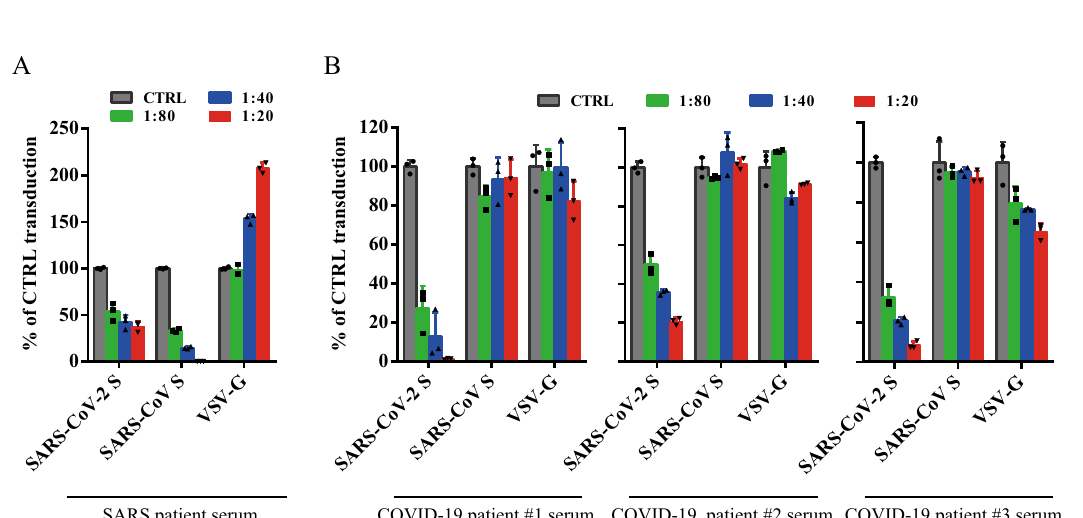
Fig. 5 Characterization of polyclonal rabbit anti-SARS S1 antibodies T62. a Binding of polyclonal rabbit anti-SARS S1 antibodies T62 to SARS-CoV-2, SARS-CoV S, and chimeric S proteins. HEK293T cells transiently expressing either SARS-CoV-2 S, SARS-CoV S, SARS-CoV S/nRBD, or SARS-CoV-2 S/ sRBD proteins were incubated with polyclonal rabbit anti-SARS-CoV S1 antibody T62 for 1 h on ice, followed by a FITC-conjugated secondary antibody, then cells were analyzed by fl ow cytometry. Experiments were done three times and one representative is shown. b Expression of SARS-CoV-2 S, SARS- CoV S, or chimeric S proteins on 293T cells. Cells from panel A were lyzed and blotted with anti-FLAG M2 antibody and polyclonal anti-SARS S1 antibody T62. c Amino acid sequence alignment of SARS-CoV and SARS-CoV-2 S RBDs. Stars (*) indicate the seven critical residues different between SARS-CoV-2 and SARS-CoV RBDs. d Binding of polyclonal rabbit anti-SARS S1 antibodies T62 to mutant SARS-CoV S proteins. e Neutralization of SARS-CoV-2 S and SARS-CoV S pseudovirions by polyclonal rabbit anti-SARS S1 antibody T62. Pseudovirons were pre-incubated with serially diluted polyclonal rabbit anti- SARS S1 antibodies T62 on ice, then virus-antibody mixture was added on 293/hACE2 cells. Pseudoviral transduction was measured 40 h later. Experiments were done in triplicates and repeated twice, and one representative is shown. Error bars indicate SEM of technical triplicates. Source data are provided as a Source Data fi le.